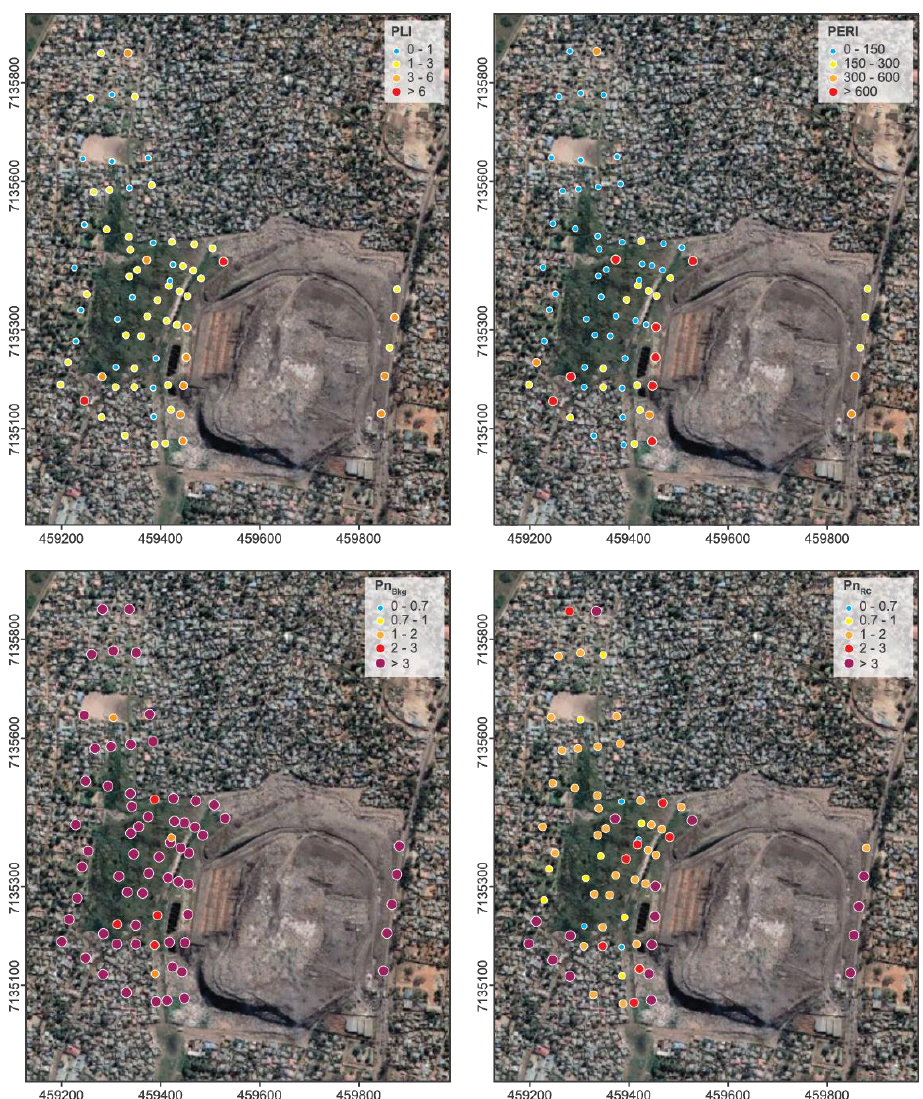
Figure 4. Potential ecological risk index (PERI), pollution load index (PLI), and soil Nemerow index calculated with local background soils and with world soils proposed by Reimann and Caritat